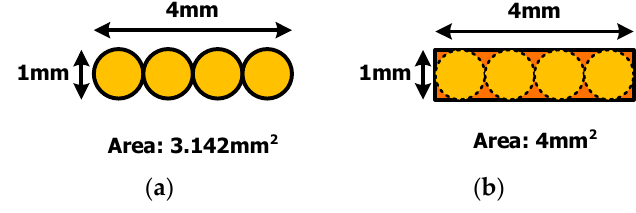
Figure 12. Winding usage in different transformers: ( a ) litz wire and ( b ) planar trace.